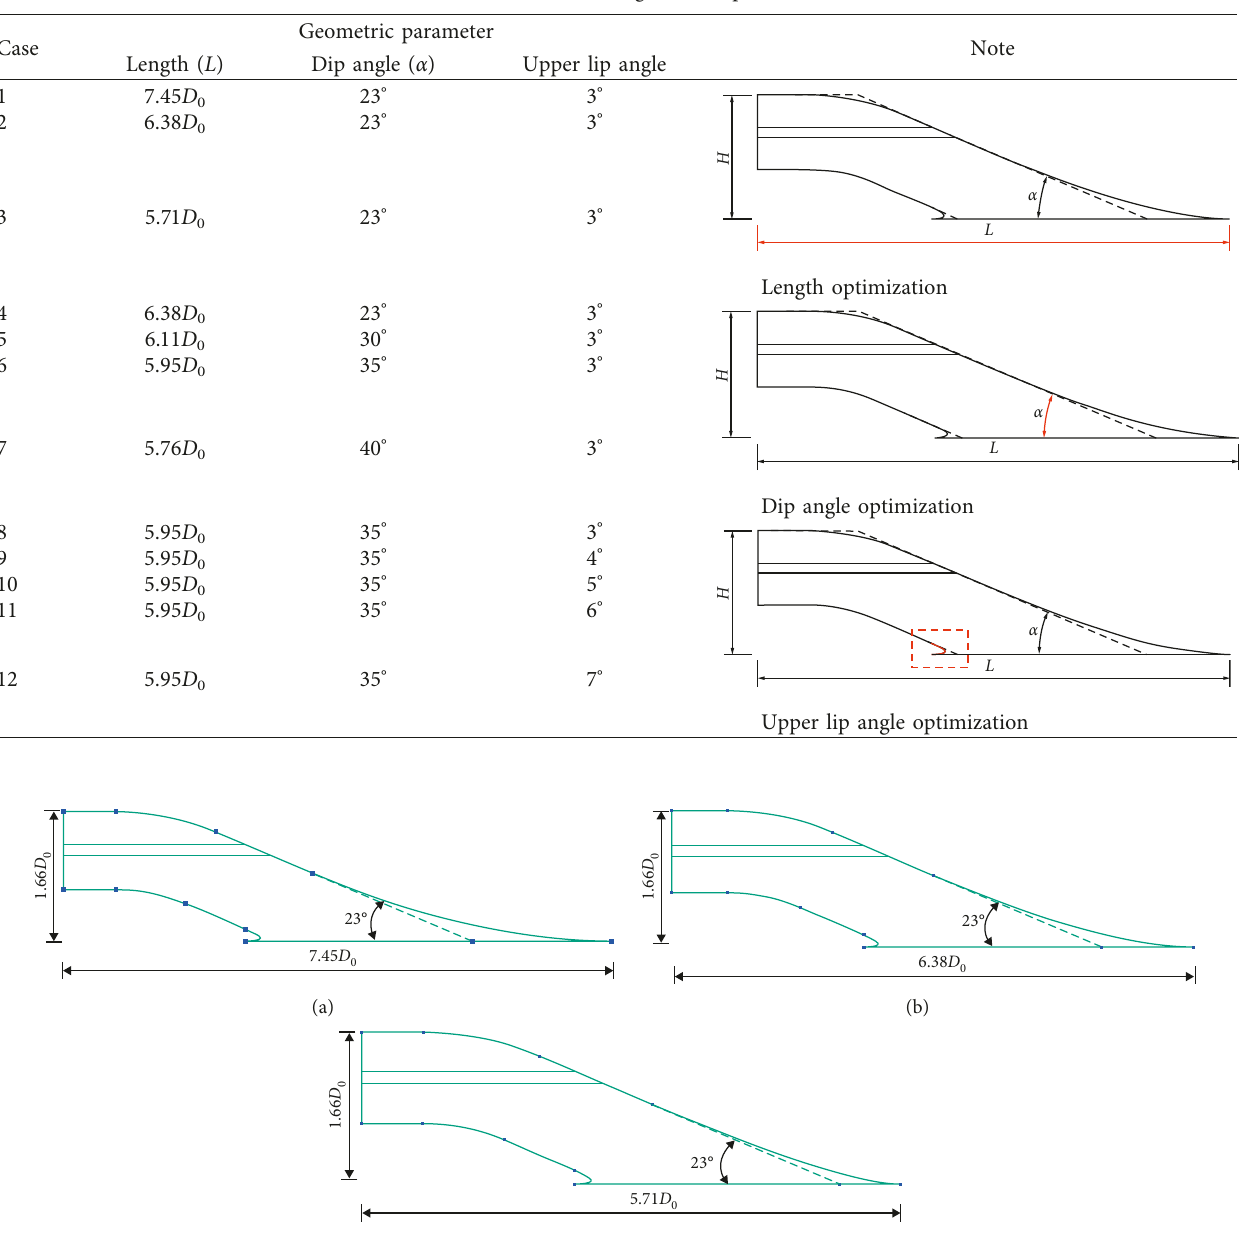
Table 4: Research case of geometric parameters.